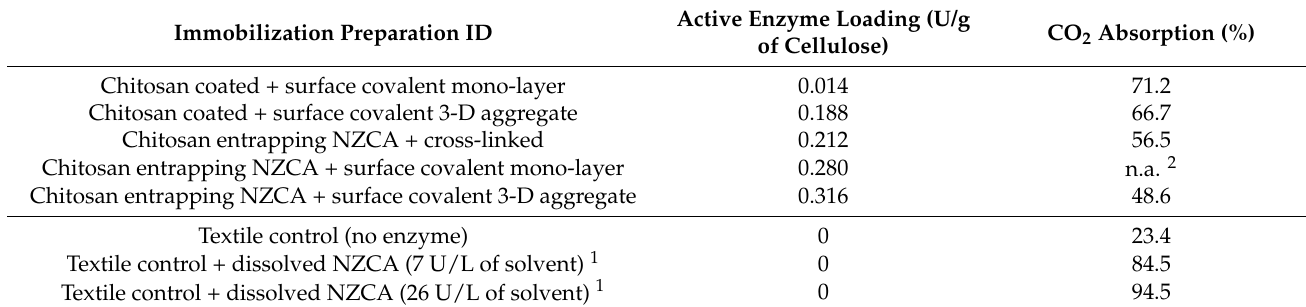
Table 3. Active enzyme loadings measured for different immobilization strategies by the esterase assay, compared to the maximum CO 2 absorption measured in a laboratory scrubber at L/G 30 mL/L using 10 wt% K 2 CO 3